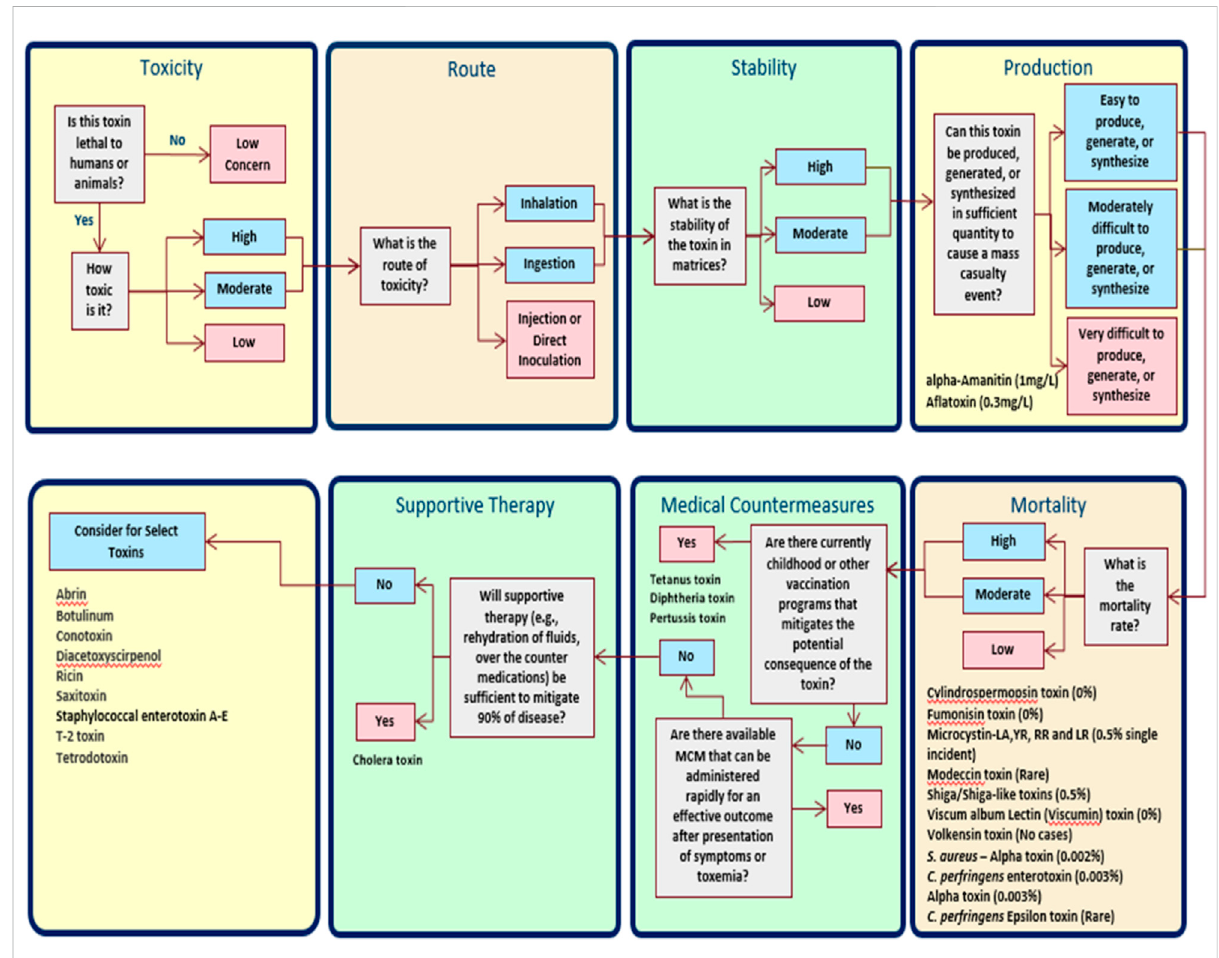
FIGURE 1 Assignments of Select and non-Select Toxins using DSF. If the result of any of the modules shows that a candidate toxin is of low risk with respect to that speci fi cparameter, the toxin is removed from consideration, theoutput is fl agged by apink box, and there is no outgoing arrow — the analysisstops.Iftheanalysisshowsthatthetoxinisofhighormoderaterisk,thecorrespondingoutputboxisblue,andanarrowcontinuestothenext